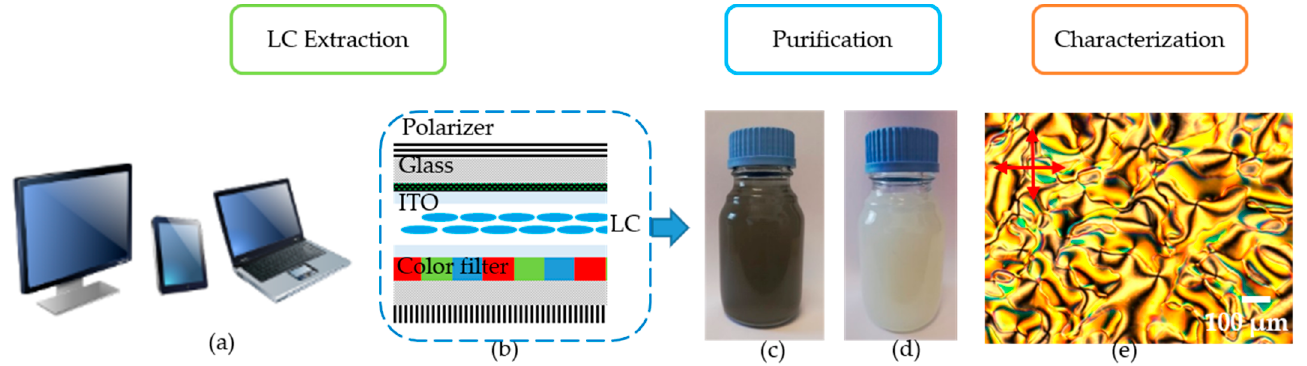
Figure 6. ( a ) End-of-life LCD, ( b ) LCD display composition, ( c ) Non-purified and ( d ) purified LCs mixtures, and ( e ) Texture of purified LC mixtures observed under polarizing optical microscope (POM) Olympus BX60 (Olympus Corporation, Tokyo, Japan), presenting a nematic Schlieren texture. Conditions: LC sample sandwiched between un-aligned glass and coverslip; crossed polarizers; and room temperature.